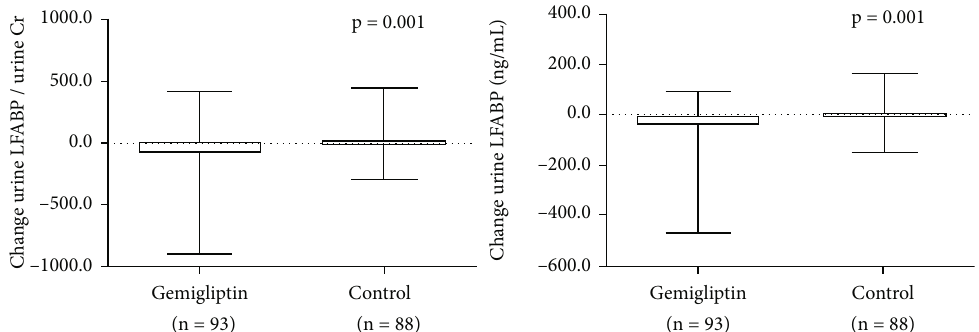
Figure 5: Comparisons between urine LFABP and urine LFABP factors for urine creatinine in both groups at baseline and at the end of the